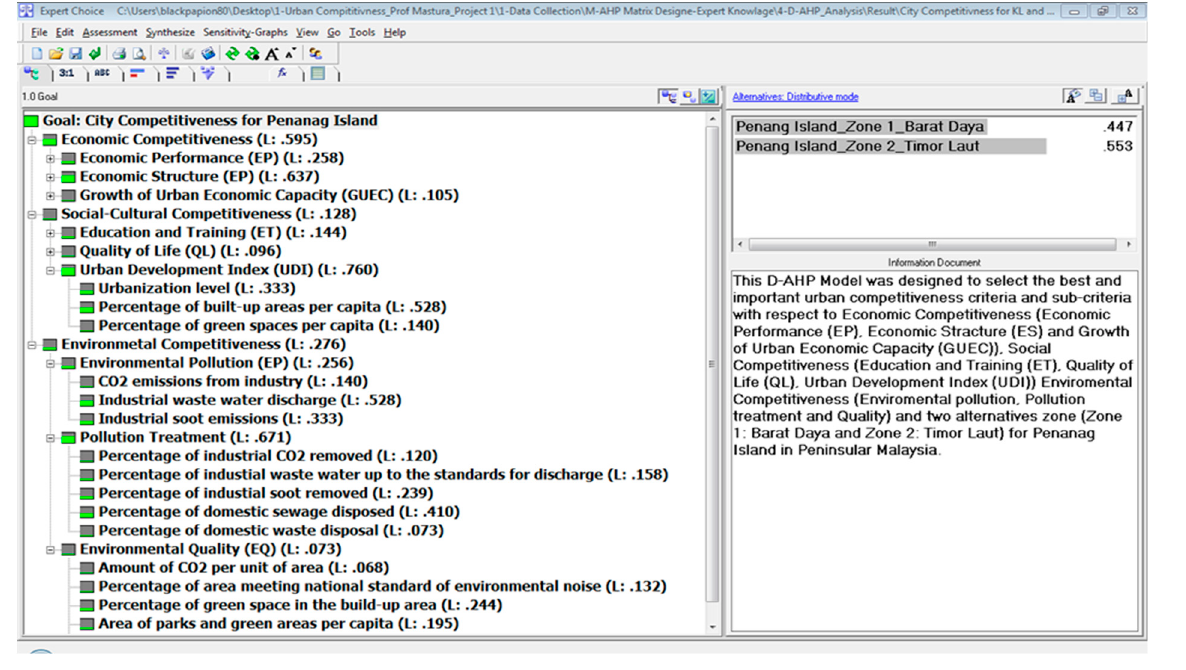
Table 2. The fundamental scale of absolute numbers. Source: [75].